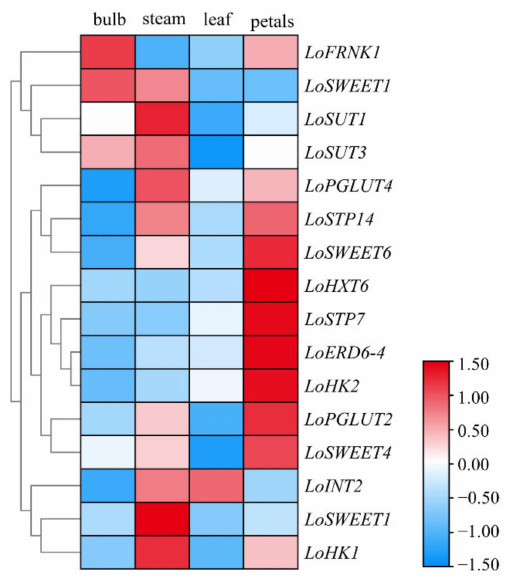
Figure 3. Tissue-specific expression of ST genes in lily. The color scale is displayed on the right side, and the color from red to blue indicates the pression level from high to